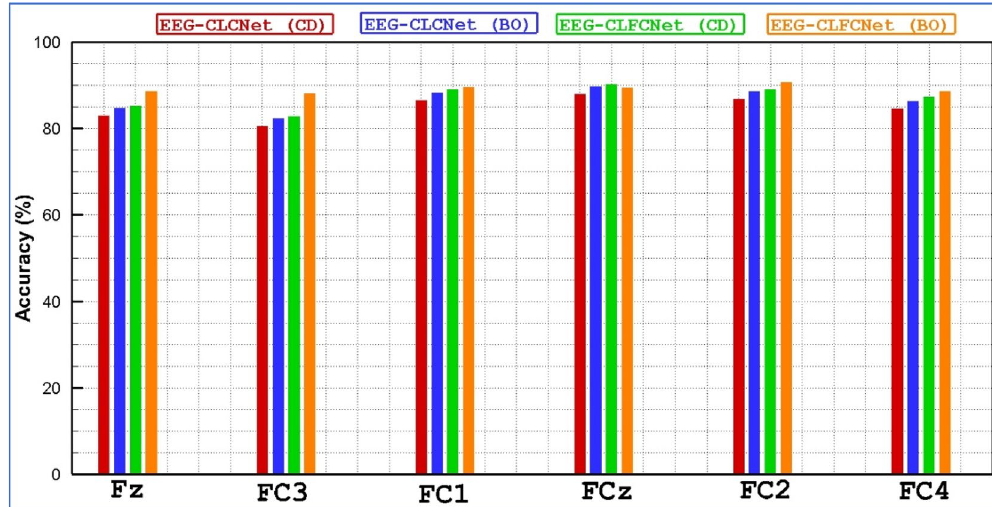
Figure 5. Accuracy of BCI Competition IV dataset 2a channels for the customized networks, with or without use of FNB and with two hyperparameter tuning methods. The horizontal axes presents the Frontal lobe channels (Fz, FC3, FC1, FCz, FC2, FC4) and the vertical axes presents the accuracy.